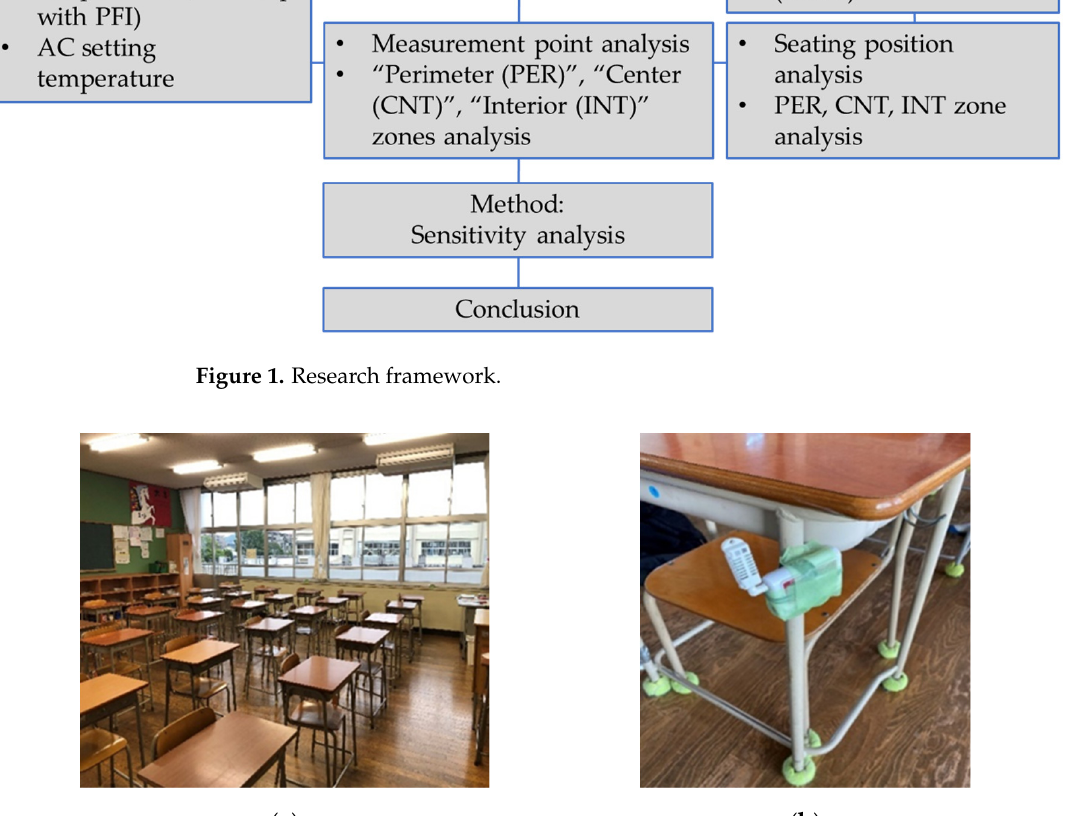
Figure 1. Research framework.